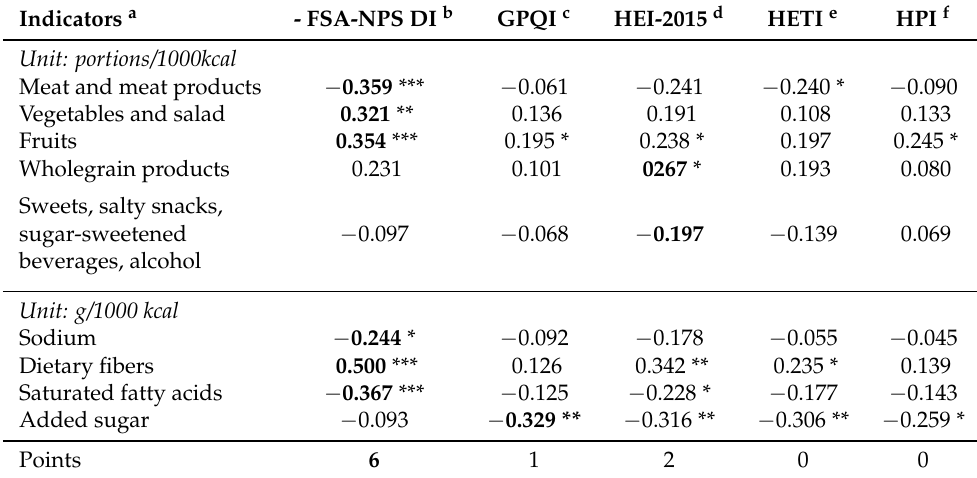
Table 5. Pearson correlation coefficients between food shopping quality indicators and relative individual daily nutritional intake, N =